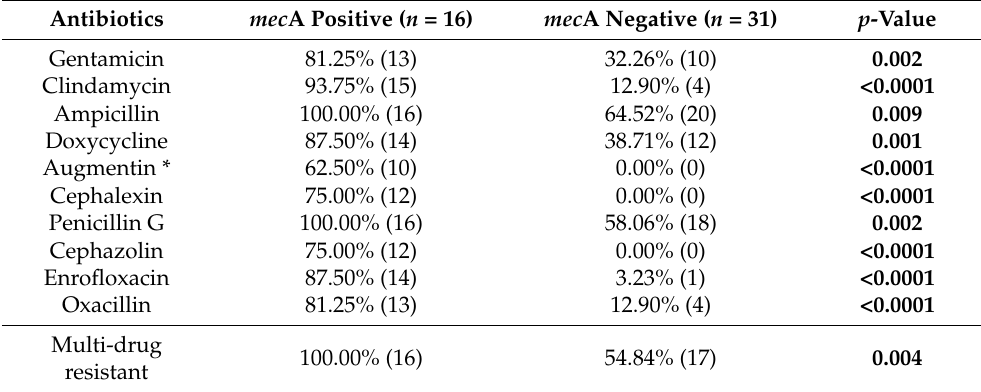
Table 2. Antibiotics resistant profiles comparing between mec A positive and negative of S. pseudinter- medius from